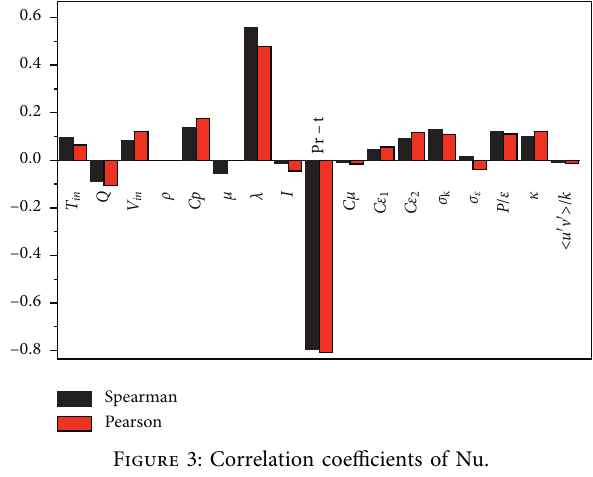
Figure 3: Correlation coefficients of